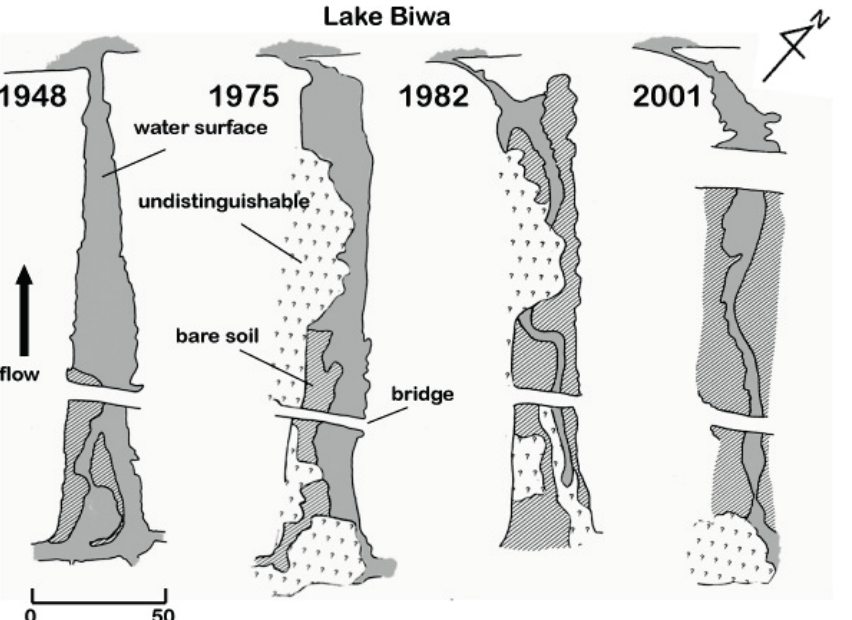
Fig. 3 Geomorphological maps of the river mouth area of Kitagawa Brook in 1948, 1975, 1982 and 2001. The maps were traced from aerial photographs obtained from the Geospatial Information Authority of